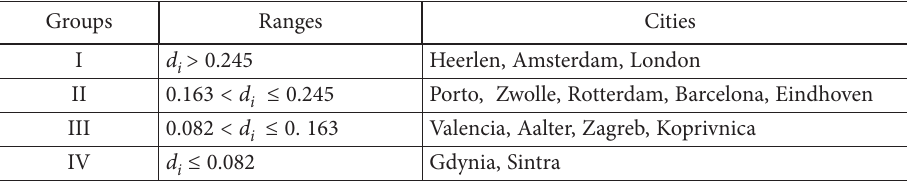
Table 5. The classification of European cities by their level of development Groups Ranges Cities